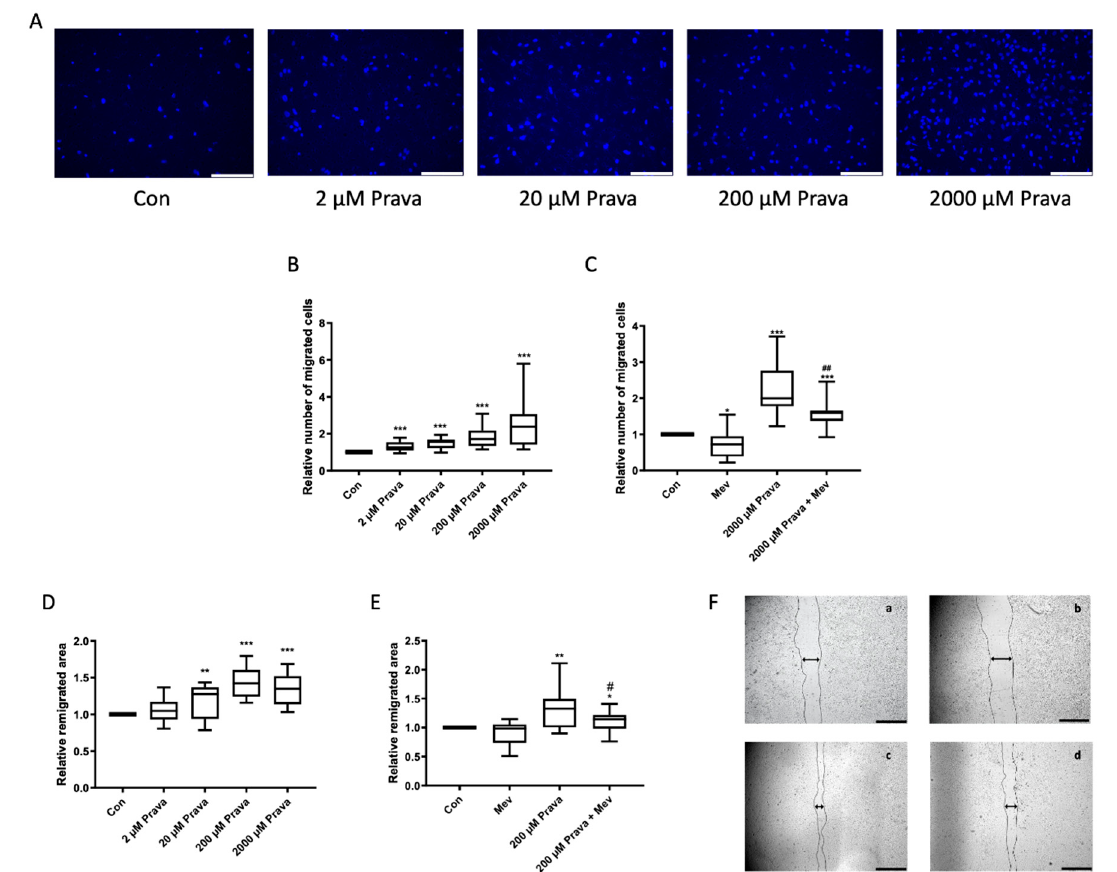
Figure 1. Pravastatin increased endothelial colony ‐ forming cells’ (ECFCs’) migration. ( A ) Representative images of 4 ′ ,6 ‐ diamidino ‐ 2 ‐ phenylindole (DAPI) ‐ stained migrated ECFCs treated with pravastatin (2, 20, 200 and 2000 μ M) in a chemotaxis assay, scale bar 150 μ m. ( B ) ECFCs showed a significantly higher directional migration in the presence of pravastatin after 4 h. ( C ) Mevalonate (200 μ M) decreased directional migration and, in combination with pravastatin (2000 μ M), significantly decreased the pravastatin induced increase in directional migration. Further representative images can be found in Supplemental Figure S1. Numbers of DAPI ‐ stained migrated cells on the lower side of the membranes were counted in each picture, n = 15–20. ( D ) Pravastatin treatment (2, 20, 200 and 2000 μ M) of ECFCs enhanced wound closure assessed as remigrated area after 18 h compared to control. ( E ) Mevalonate (200 μ M) alone had no significant effect on ECFCs’ migration, but its addition to pravastatin (200 μ M) reduced the pravastatin effect significantly. ( F ) Representative images of monolayers with scratch wounds at 18 h of incubation with culture medium only (a), 200 μ M mevalonate (b), 200 μ M pravastatin (c) and combination of 200 μ M pravastatin and 200 μ M mevalonate (d), scale bar 1000 μ m. Cell ‐ free area after 18 h was subtracted from cell ‐ free area at start to calculate remigrated area. n = 14–16. Con, control; Prava, pravastatin; Mev, mevalonate. * p < 0.05, ** p < 0.01, *** p < 0.001 compared to control, # p < 0.05 compared to 200 μ M pravastatin, ## p < 0.01 compared to 2000 μ M pravastatin; ( B – E ) control group set as 1.